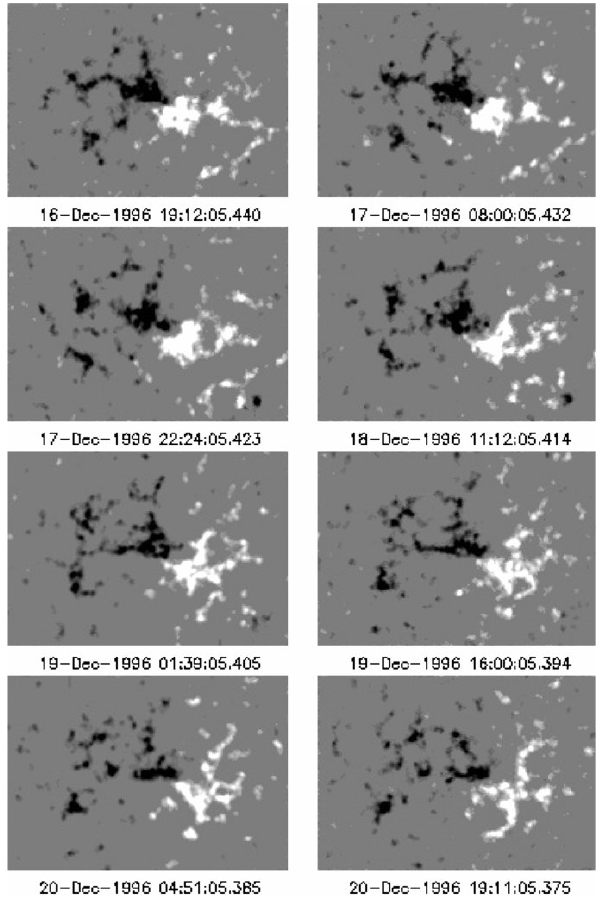
Figure 13: Evolution of NOAA AR 8005 over four days (CMP: 18 December 1996; white: positive, black: negative polarity; SOHO MDI LOS magnetograms). Image reproduced with permission from Mackay et al. (2011), copyright by